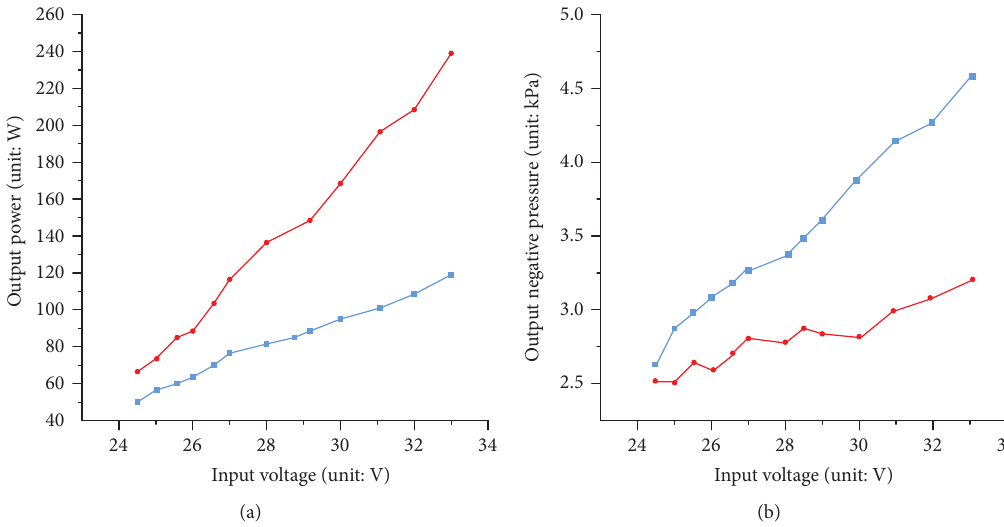
Figure 8: Pressure generator performance under different inlet situations. (a) Comparison of output power. (b) Comparison of output pressure.